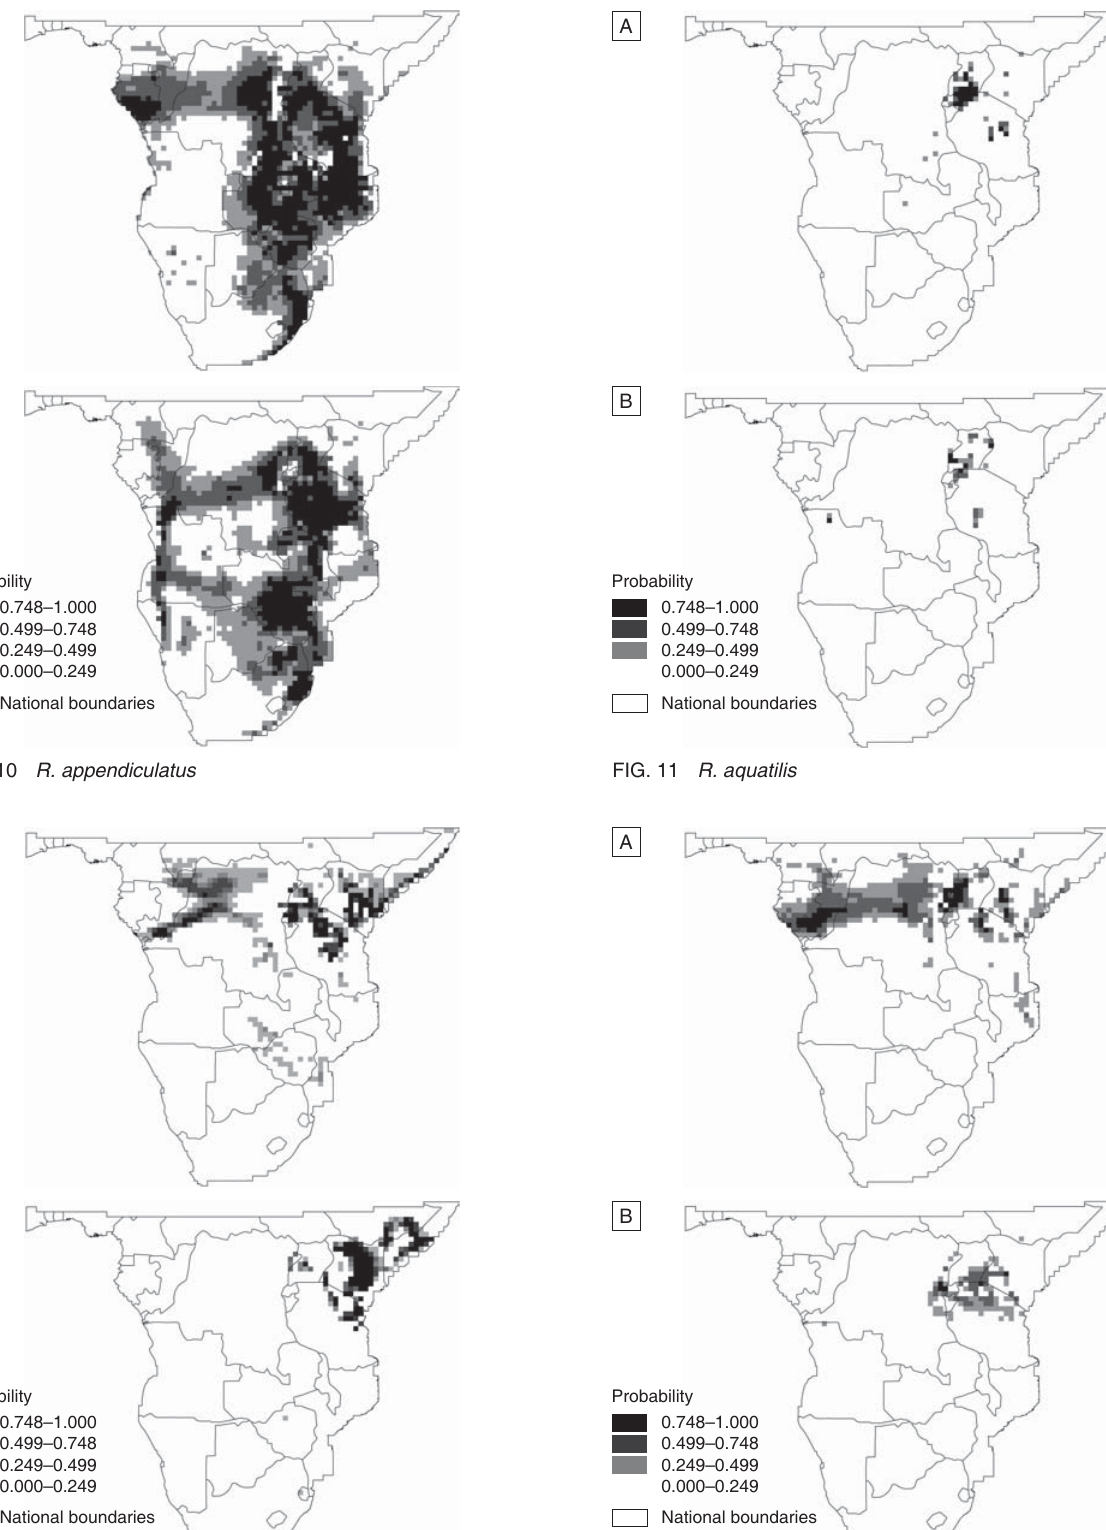
FIG. 10–39 Predicted probability distribution of Rhipicephalus species using DARLAM and GCM future climates: (A) DARLAM; (B) GCM